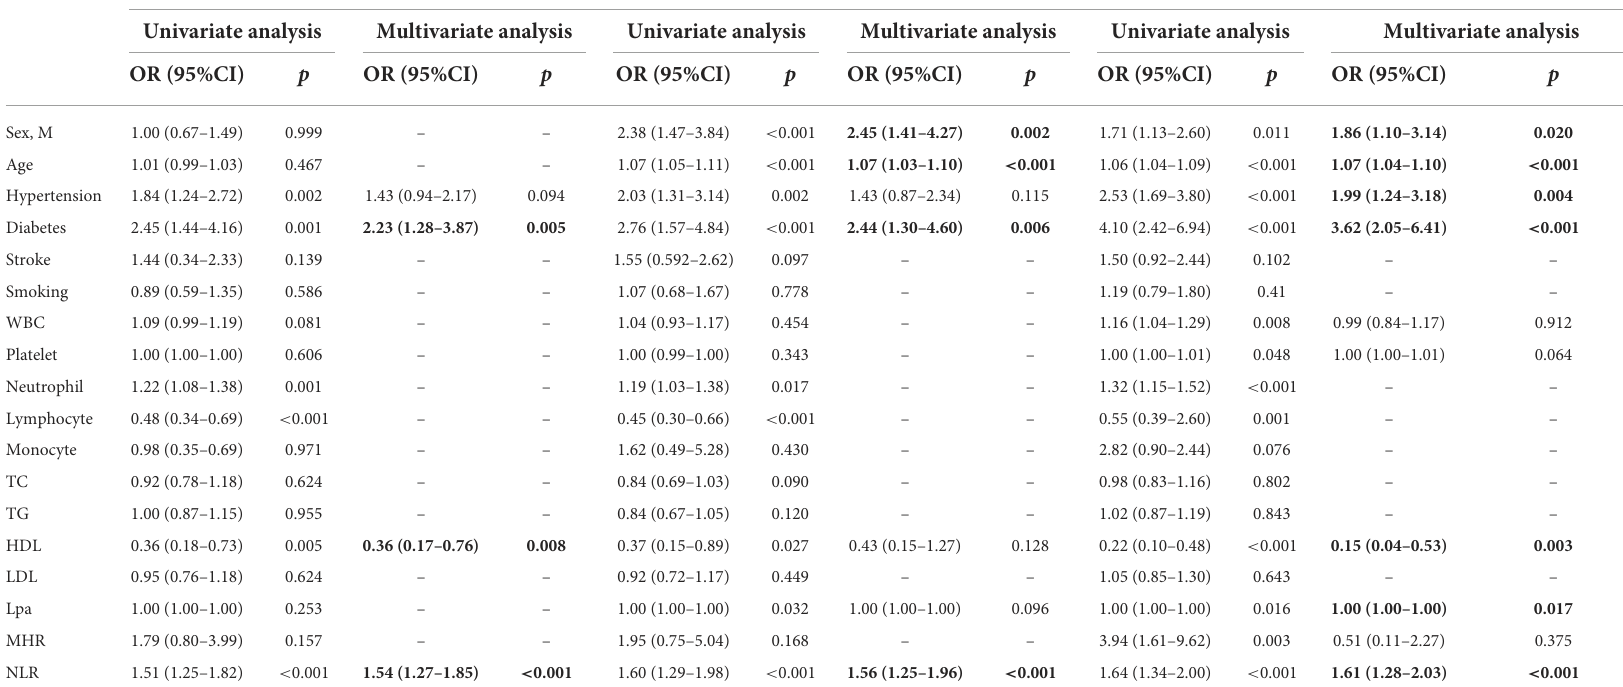
TABLE 2 Univariate and multivariate logistic regression analysis of factors for the distribution of atherosclerotic